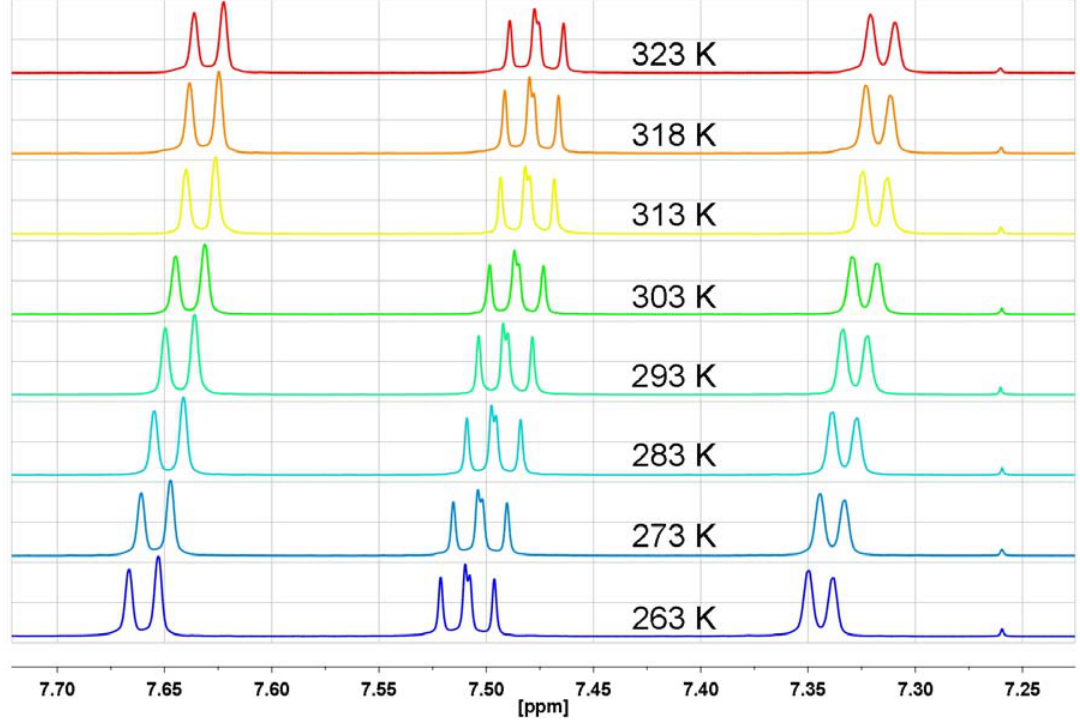
Figure 14. The aromatic proton region of the 1 H-NMR spectrum in CDCl acenaphthene at different temperatures.